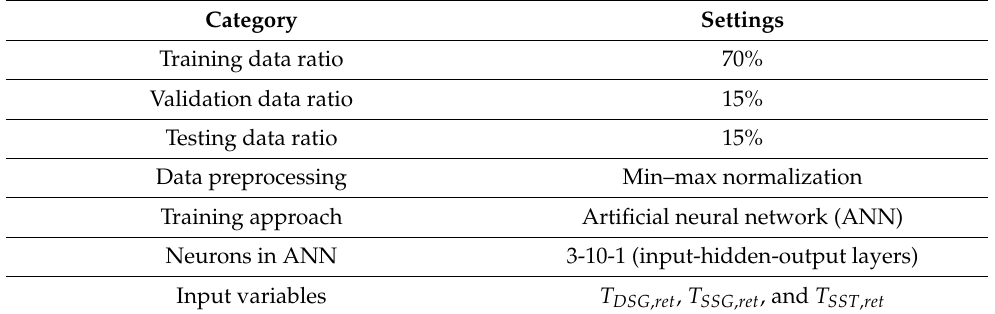
Table 3. Virtual sensor modeling description for T DM , ret .